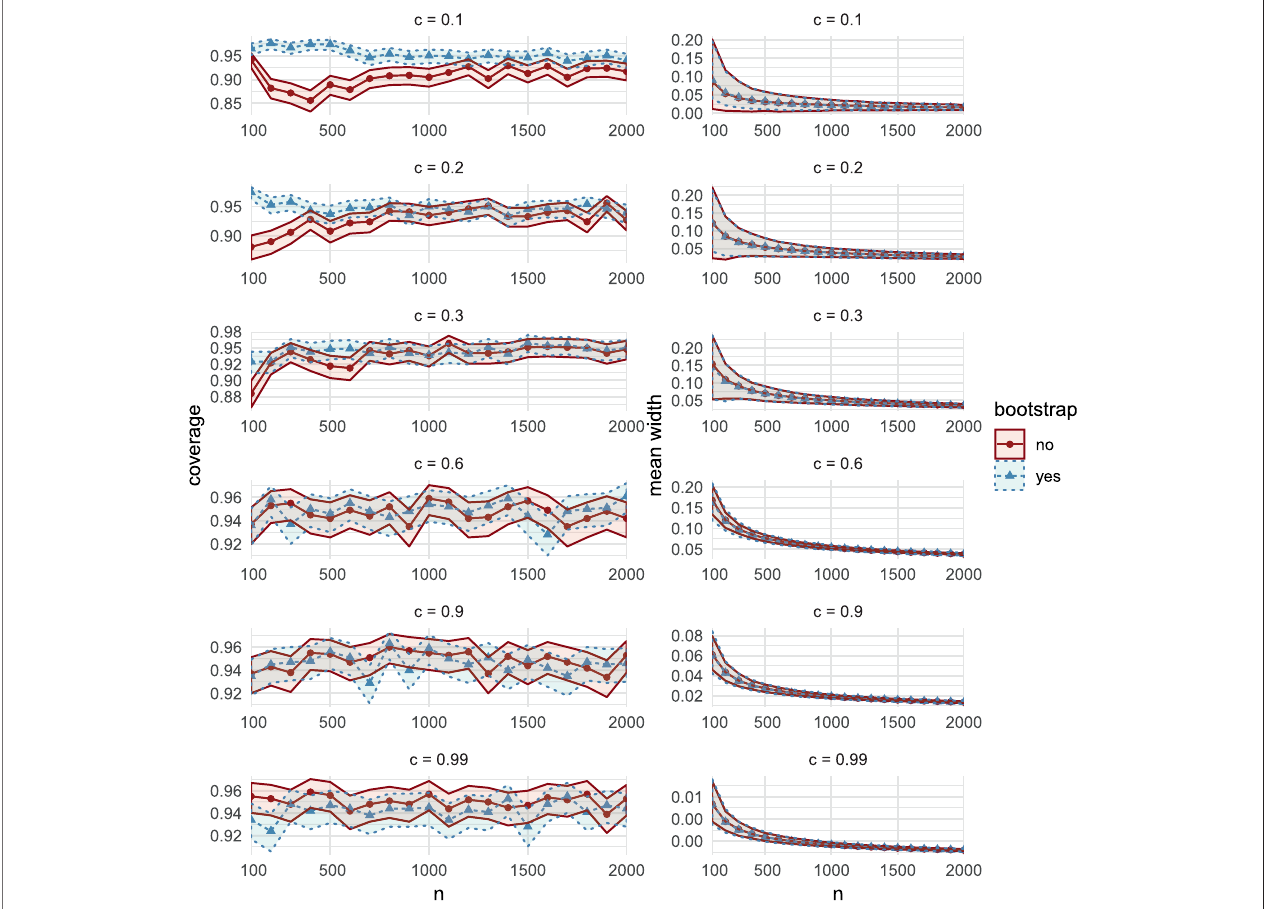
FIGURE 1 | Comparisons of coverage (left column) and mean width (right column) , between the bootstrap CIs (dashed lines with triangular markers) and the asymptotic CIs (solid lines with circular markers) in MC Study A. Rows represent correlations c, increasing from 0.1 on the top row to 0.99 on the bottom row. The horizontal axes display the sample sizes n (cid:2) 100 , 200 , ... ,